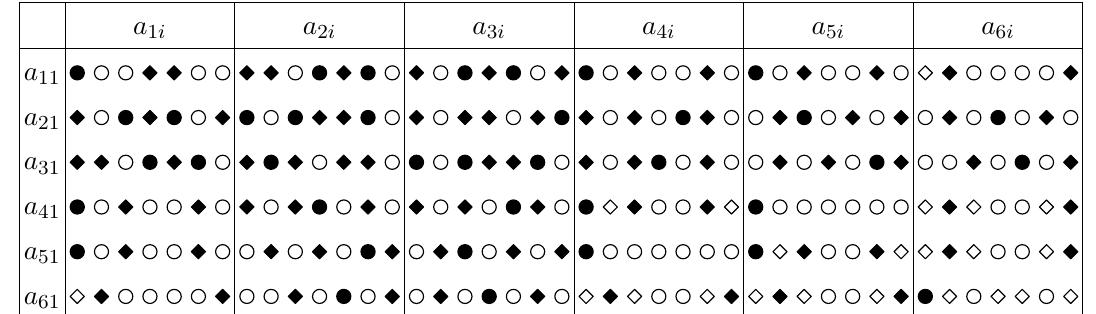
Table 3. The neighbourhood and connectivity relations of the coordinates a i 1 with the 42-letter alphabet. Other relations can be inferred by cyclic